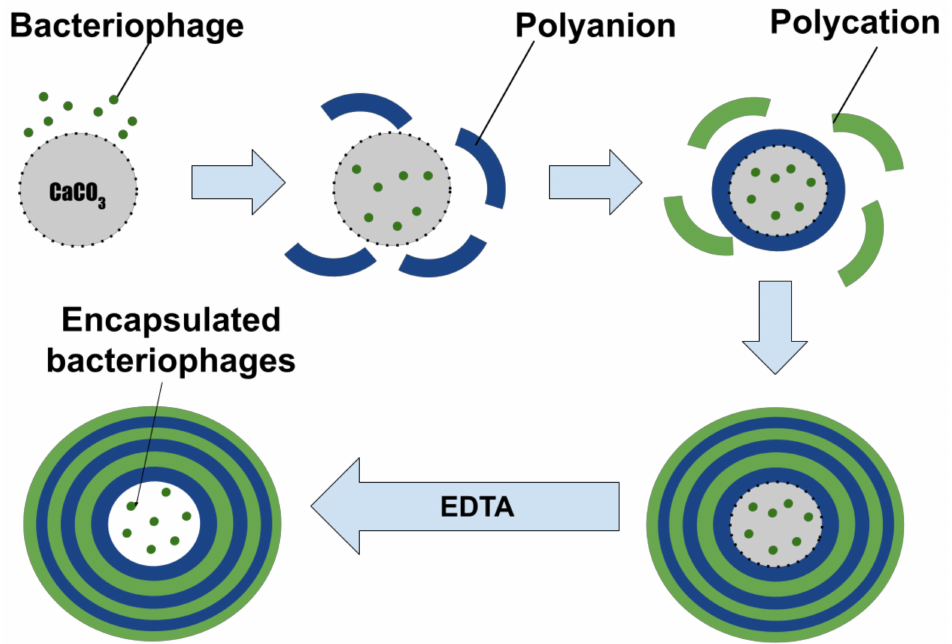
Figure 1. Scheme of polyelectrolyte microcapsule